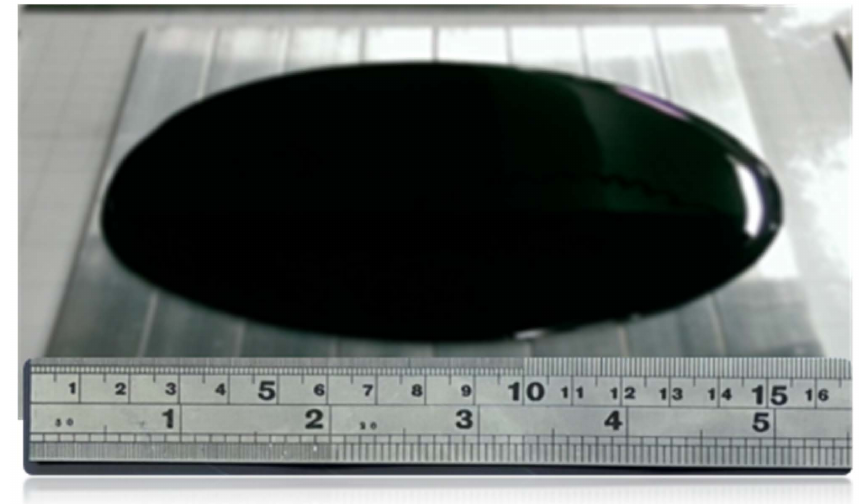
Figure 1. GNP/epoxy nanocomposite poured onto an Al